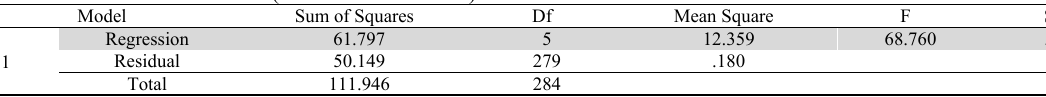
Test the relevance of the model (Variance - ANOVA)